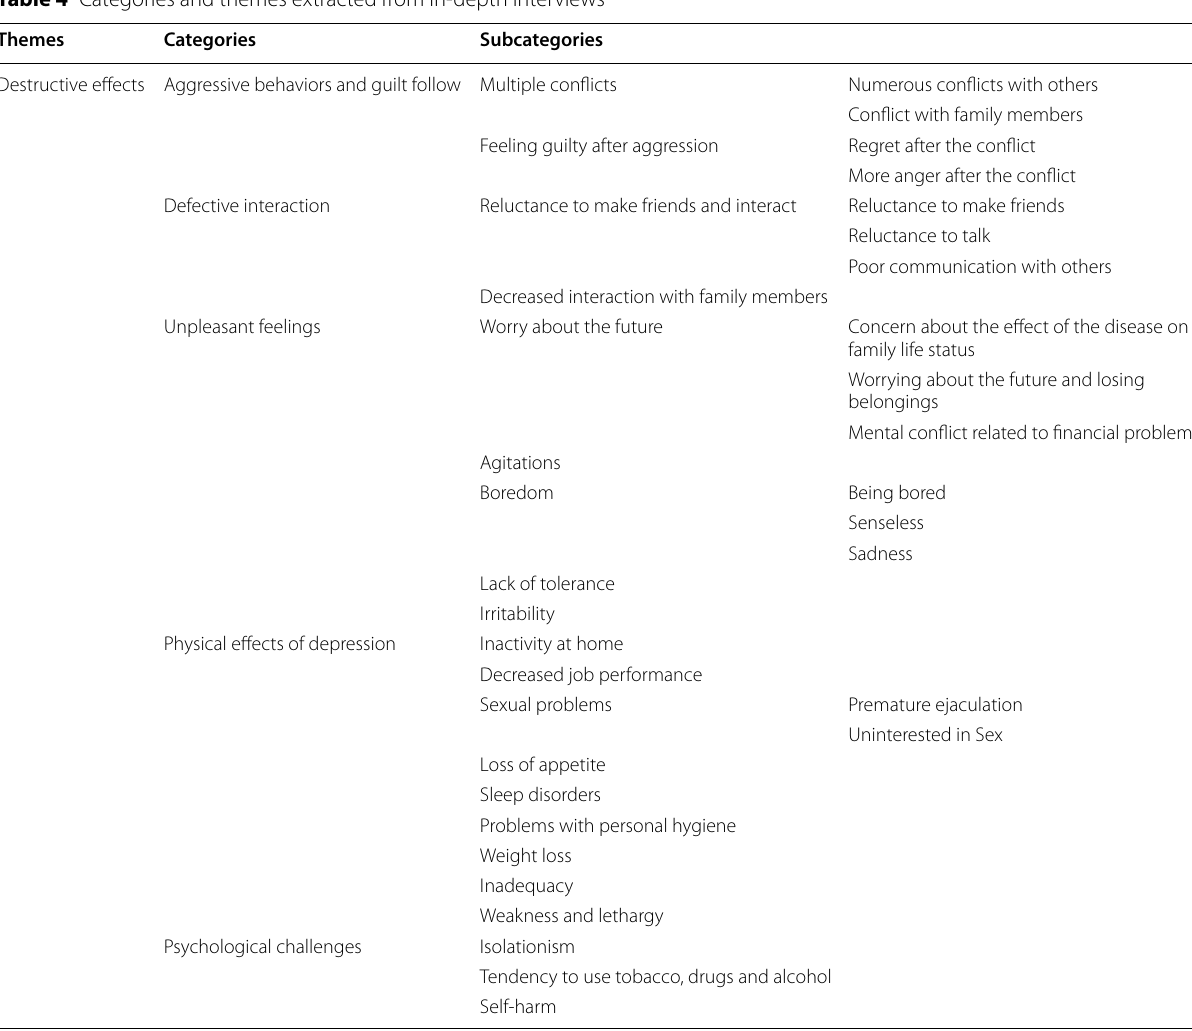
Table 4 Categories and themes extracted from in-depth interviews